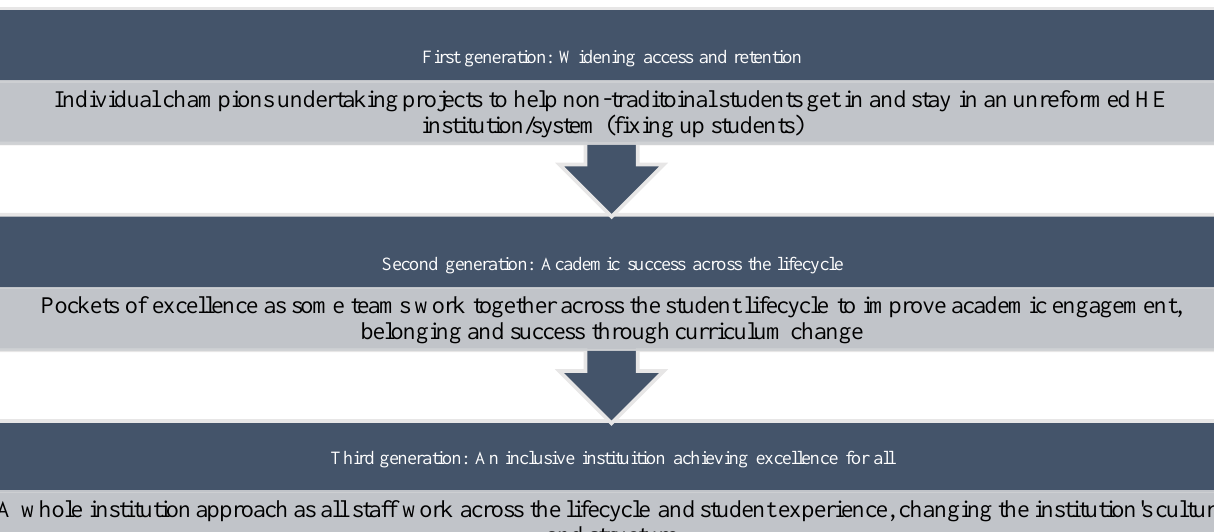
Figure 1 Widening Participation Maturity